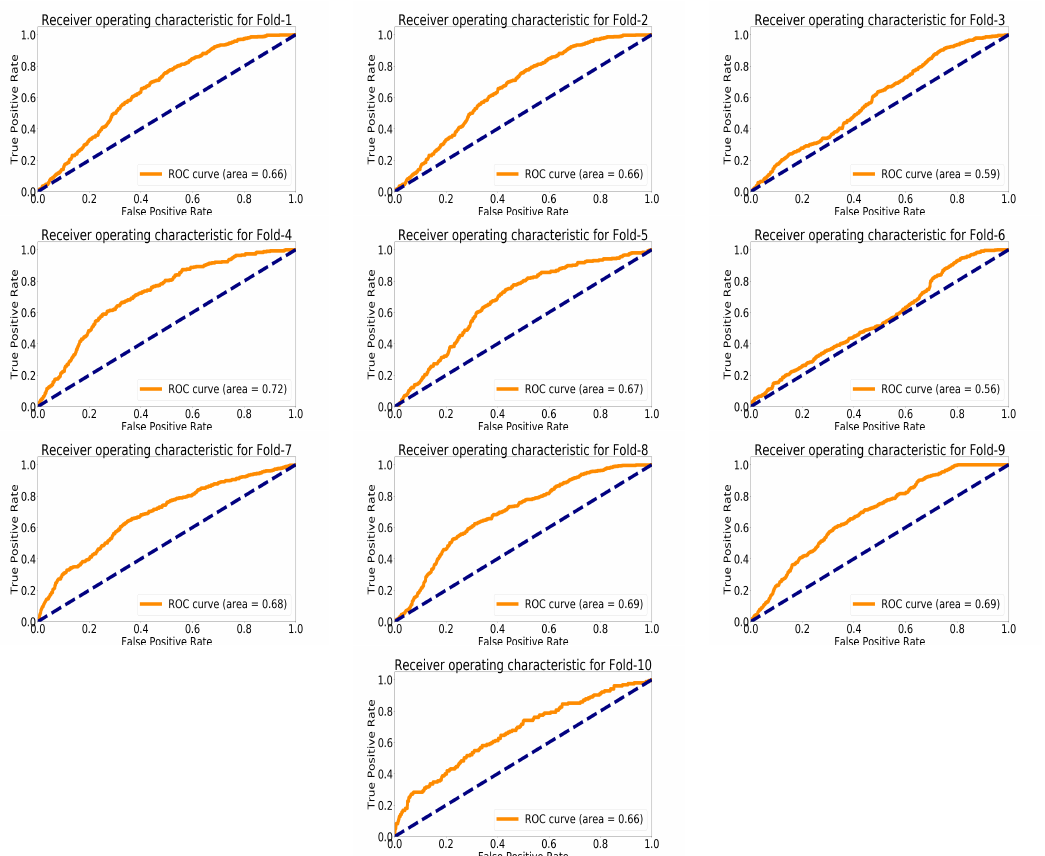
Figure 10. Roc Curve Estimated for each Fold after applying the combinatory